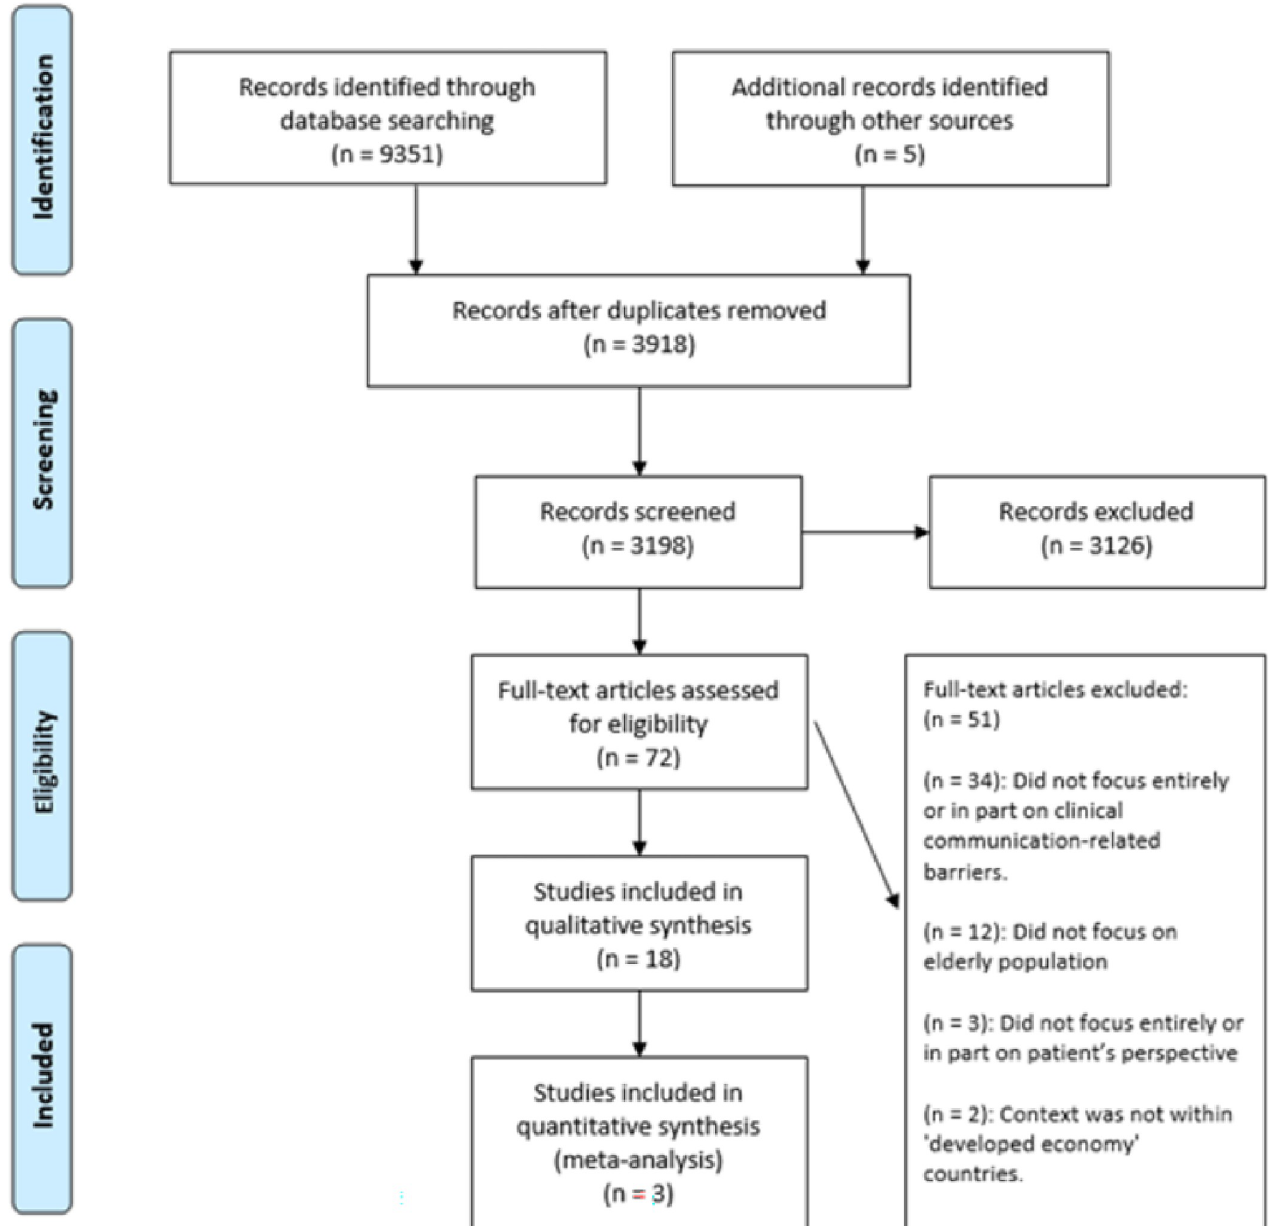
Fig 1. PRISMA flowchart of the studies retrieved and selection